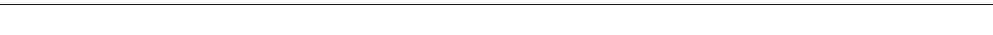
Fig. 6 3 ′ end formation and splicing in A-ROD function. a UCSC genomic screenshot showing A-ROD expression tracks and positions of the assayed RT- qPCR amplicons. P-Ser2 Pol II ChIP-seq is from 74 . Sequences of the PAS and CPA target sites of 2 ′ -O-MeRNA-PS oligo blockers are underlined. b Normalized RT-qPCR of BrU-labeled nascent chromatin-associated RNA in MCF-7 cells treated either with control or 2 ′ -O-MeRNA-PS oligo blockers targeting the PAS and/or CPA site. Error bars represent standard deviations from three independent experiments ( n = 3 biological replicates, ** p < 0.01, two-tailed Student ’ s t -test). c P-Ser2 Pol II ChIP recovery (% of Input) in control; MCF-7 cells treated with 2 ′ -O-MeRNA-PS oligo blockers targeting the PAS and/or CPA site; and MCF-7 cells treated with morpholinos targeting either the donor splice site (mo.sj3) or the acceptor splice site (mo.sj4) of the second intron of A-ROD. Positions of the morpholinos are depicted in ( a , d ). Error bars represent standard deviations from three independent experiments ( n = 3 biological replicates, * p < 0.05 and ** p < 0.01, two-tailed Student ’ s t -test). d Schematic representation of A-ROD exonic structure and PCR analysis of the premature (non-spliced) and mature (spliced) forms of A-ROD in control MCF-7 cells (treated with the ‘ standard control sequence ’ morpholino) or in MCF-7 cells treated either with the mo.sj3 or the mo.sj4 in the given concentrations. In the ‘ double ’ lanes both morpholinos were pooled and cotransfected in the given fi nal concentrations. The PCR (30 cycles) was performed with primers r1 and f2 on cDNA reverse-transcribed from 200 ng total nuclear RNA primed with the ‘ rt ’ primer (see Methods section). Please note, that this PCR analysis is not quantitative and was conducted to visualize the effect of the morpholinos treatment. The accumulation of the premature product observed in lanes 5 – 8 (mo.sj3 and double.mo) is most probably due to the mo.sj3-exerted elimination of the mature form of A-ROD (hence less available spliced product to amplify) and both products being ampli fi ed by the same pair of primers, in the same reaction. To quantitatively assess the morpholino treatment effect, RT-qPCR analysis was further performed (e – g) . e Normalized to control RT-qPCR measured abundance of the mature (spliced) form of A-ROD (amplicon ‘ exon2 – exon3 ’ ) divided to the RT-qPCR measured level of the premature (non-spliced) form (amplicon ‘ pre-A-ROD.2 ’ ), in control and in MCF-7 cells treated with morpholinos as in ( d ). The RT-qPCR values used to extract the ratio spliced/pre-mature A-ROD are from RT-qPCR on total chromatin-associated RNA (cDNA primed with random primers) depicted in ( f ). f , g RT-qPCR analysis on f total chromatin-associated RNA and g nucleoplasmic RNA (in both cases random primed cDNA) in control and MCF-7 cells treated with morpholinos as in ( d ). Error bars represent standard deviations from three independent experiments ( n = 3 biological replicates, * p < 0.05 and ** p < 0.01, two-tailed Student ’ s t